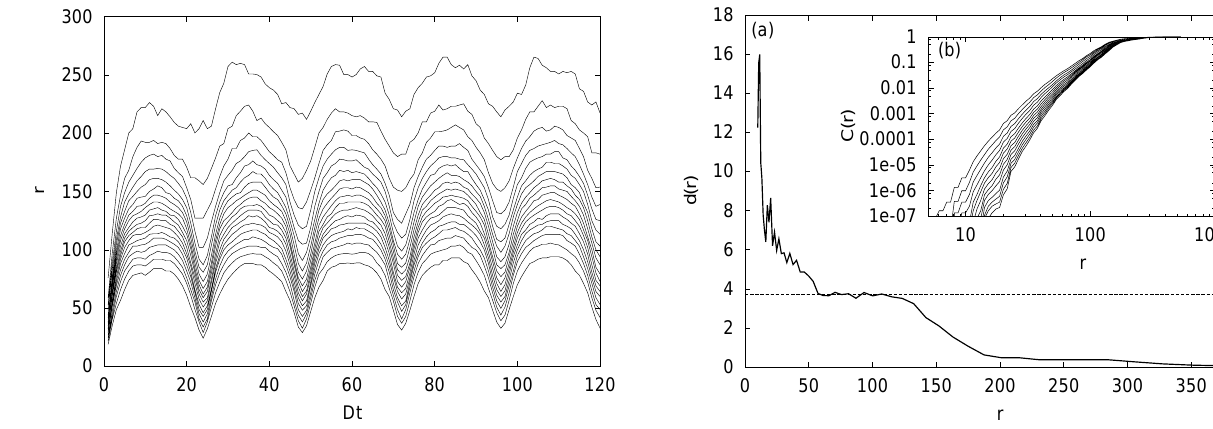
Fig. 3. The space-time separation plot for the time series of H. Initially, the curves increase quickly and later, the stable diurnal oscillations repeat.